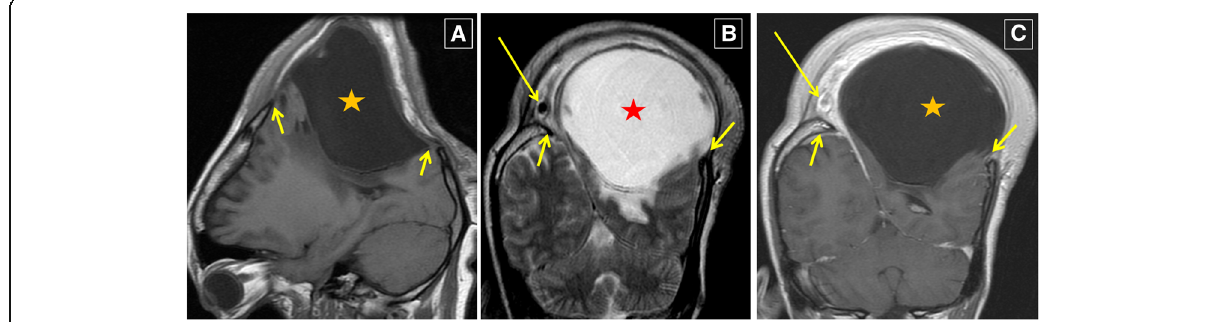
Fig. 6 Parietal encephalocele/gliocoele. ( a ) (sagittal T1 weighted), ( b ) (coronal T2 weighted), and ( c ) (T1-weighted coronal with gadolinium) images show herniation of the brain content through the defect in the left parietal bone (edges represented by short arrows). Note the presence of a large porencephalic cyst (star) at the site of herniation. The sagittal sinus (long arrows) has herniated into the